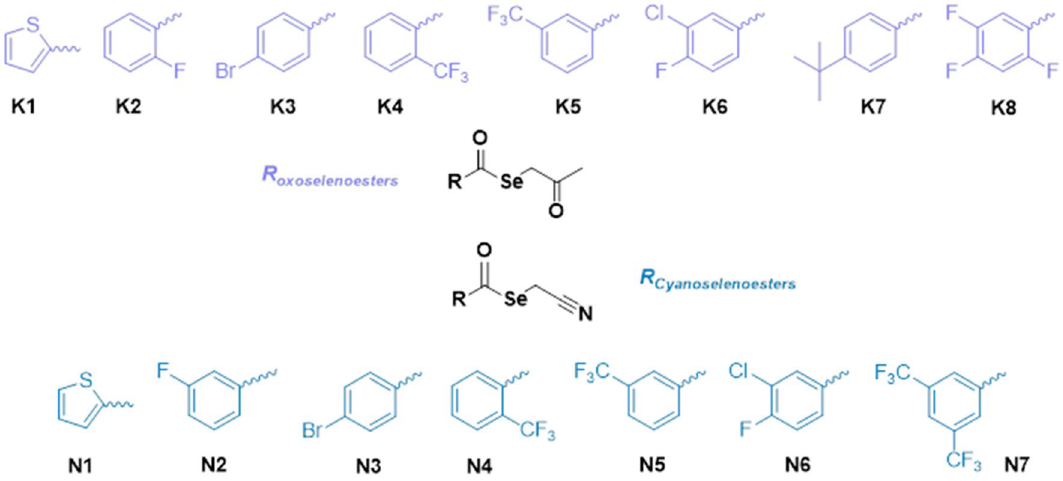
Figure 1. The structures of 15 selenocompounds used in this work: K1–K8 ketone-selenoesters and N1–N7